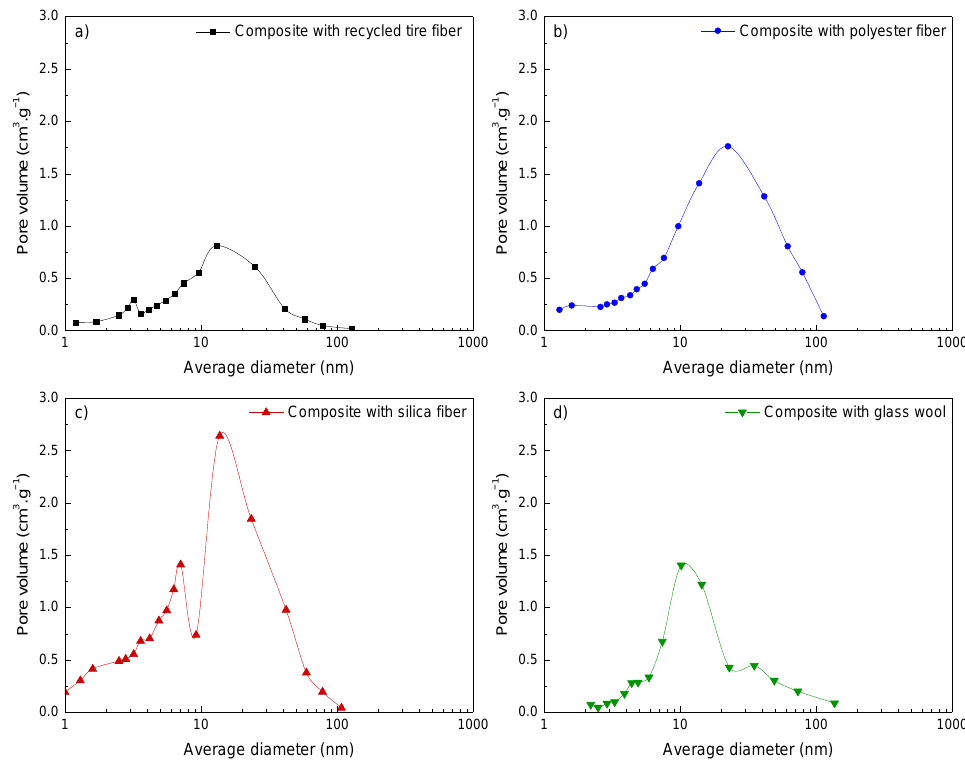
Figure 4. Pore size distribution for the rubber-silica aerogel composites reinforced with ( a ) recycled tire textile fibers; ( b ) polyester fiber blanket; ( c ) silica fiber felt; and ( d ) glass wool. To estimate the thermal stability of the composite materials, the samples were sub- mitted to a thermogravimetric analysis from 20 ◦ C to 600 ◦ C (Figure 5). For the